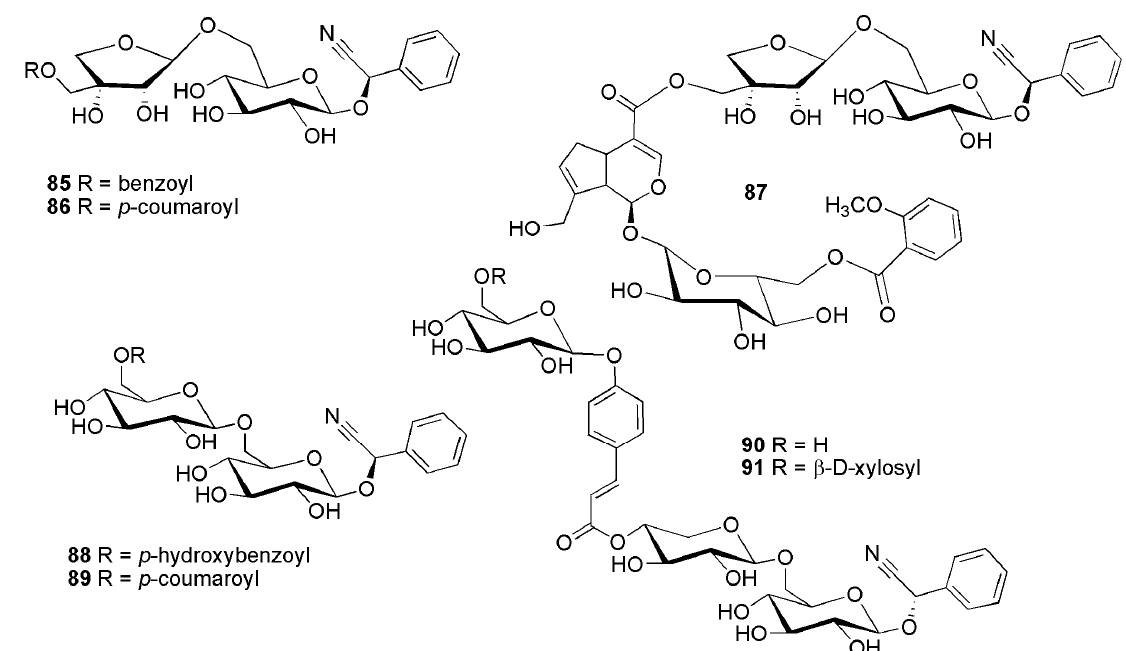
Figure 14. Cyanogenic glycosides group C-4, acyl derivatives of phenylalanine derived cyanogenic glycosides with a disaccharide linked to the aglycone: oxyanthin 5 ″ - O -benzoate ( 85 ), hedyotoside A ( 86 ), canthium glycoside ( 87 ), amygdalin-6 ″ - p -hydroxybenzoate ( 88 ), amygdalin-6 ″ - p -coumarate ( 89 ), anthemis glycoside A ( 90 ) and anthemis glycoside B ( 91 ).